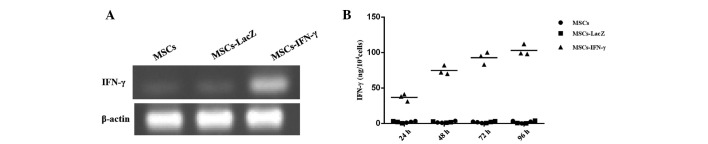
Expression of IFN-γ in MSCs transduced with the recombinant adenoviruses. (A) RT-PCR showed that the expression levels of IFN-γ mRNA were significantly higher in MSCs-IFN-γ than in the two control groups. (B) IFN-γ protein levels were evidently elevated in MSCs-IFN-γ, while its expression was fairly low in the two control groups. Experiments were repeated three times and results are presented as the mean ± SD. MSCs, mesenchymal stem cells; RT-PCR, reverse transcription polymerase chain reaction.